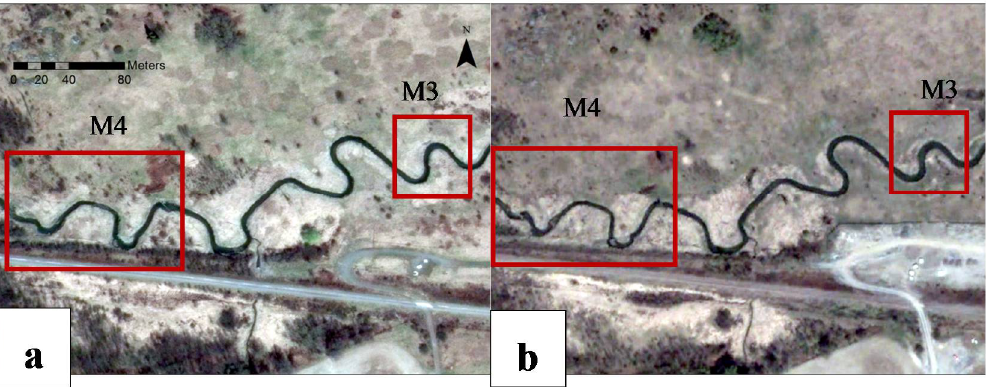
Figure 6. Aerial photo of the study reach adopted from Google Earth: ( a ) 2014 ( b ) 2004. Location of the each sampling reach is shown with the square.